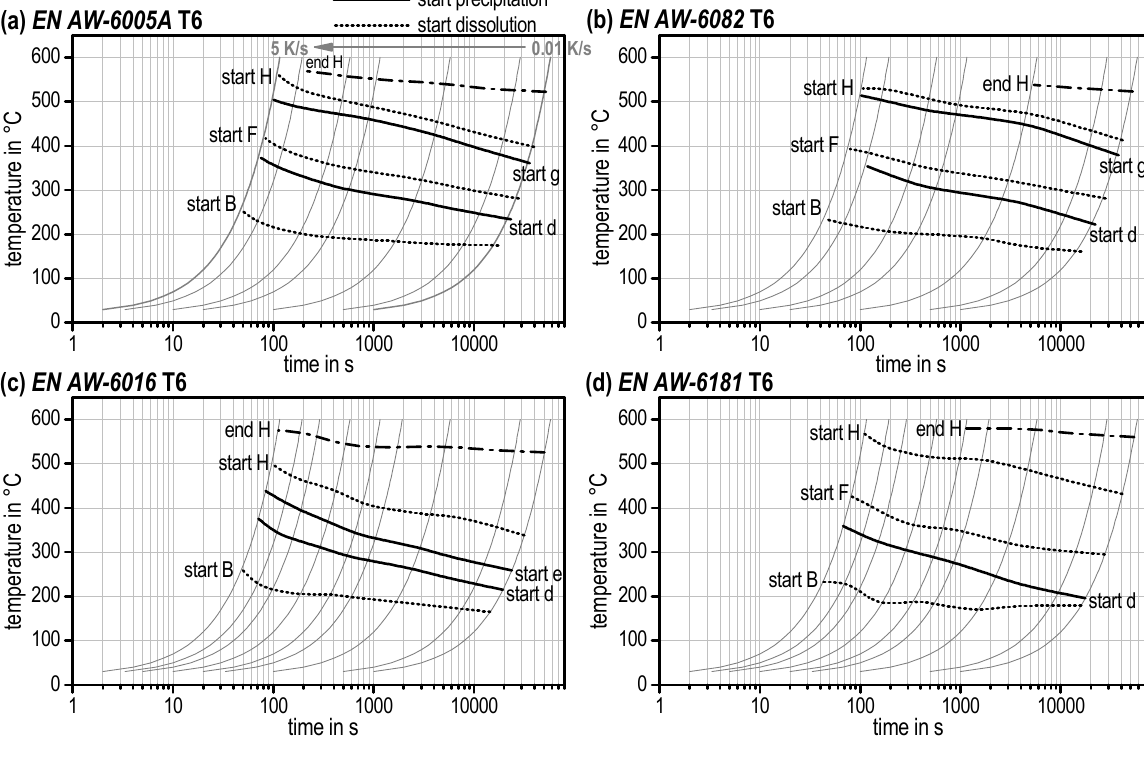
Figure 11. Continuous heating dissolution diagrams for the T6 initial condition of several aluminium alloys ( a ) EN AW-6005A. ( b ) EN AW-6082. ( c ) EN AW-6016. ( d ) EN